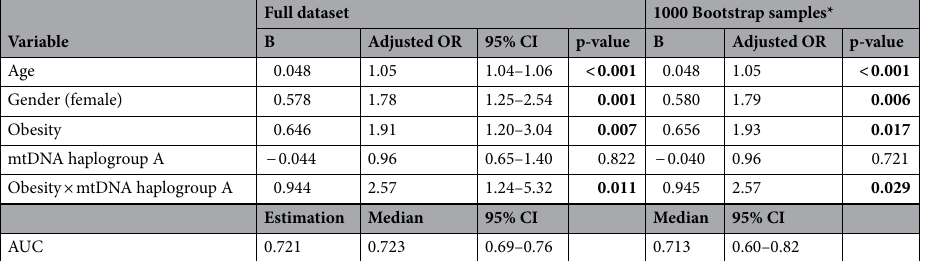
Table 5. Multivariate logistic regression model to explore the effect of the interaction between obesity and mtDNA haplogroup A on the risk of knee OA in the full dataset of Mexican subjects and results of the internal validation strategy after 1000 iterations. BMI body mass index, B regression coefficient, OR odds ratio, CI confidence interval, AUC area under the curve used as performance measure of internal validation. Statistical significance declared at p < 0.05 (in bold). *Internal validation with estimated coefficients across B = 1000 iterations reported in 75% of the full